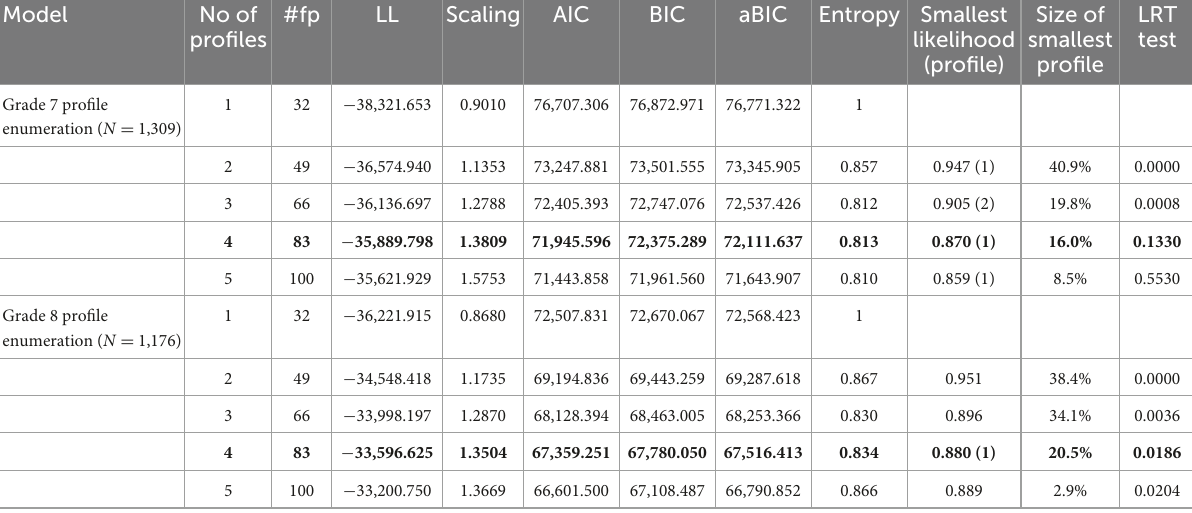
TABLE 3 Model fit criteria of the one- to five-class solutions at T1 (Grade 7) and at T2 (Grade 8). Model